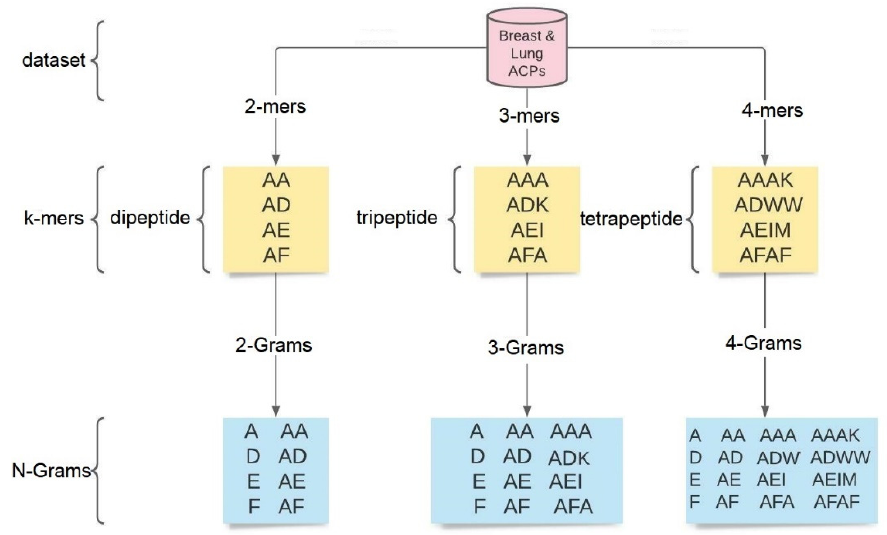
Figure 1. Encoded N-Grams extraction using k-mers.